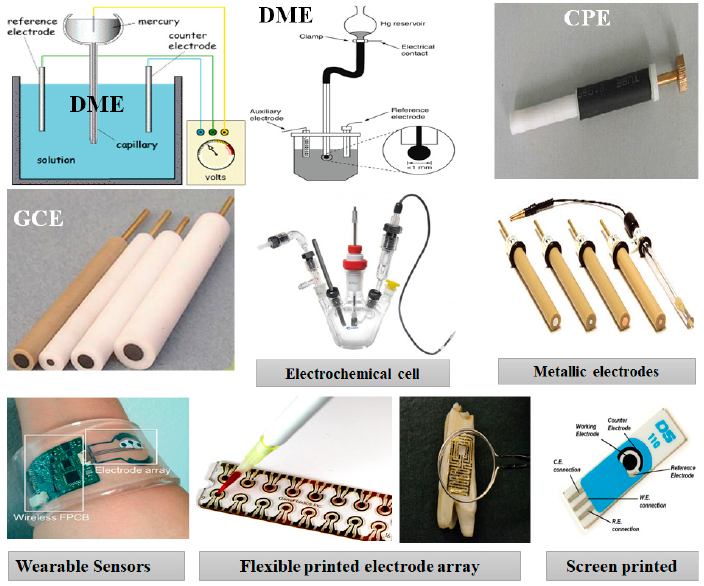
Figure 5. The most commonly used working electrode types and materials in electrochemical sensors and biosensors.